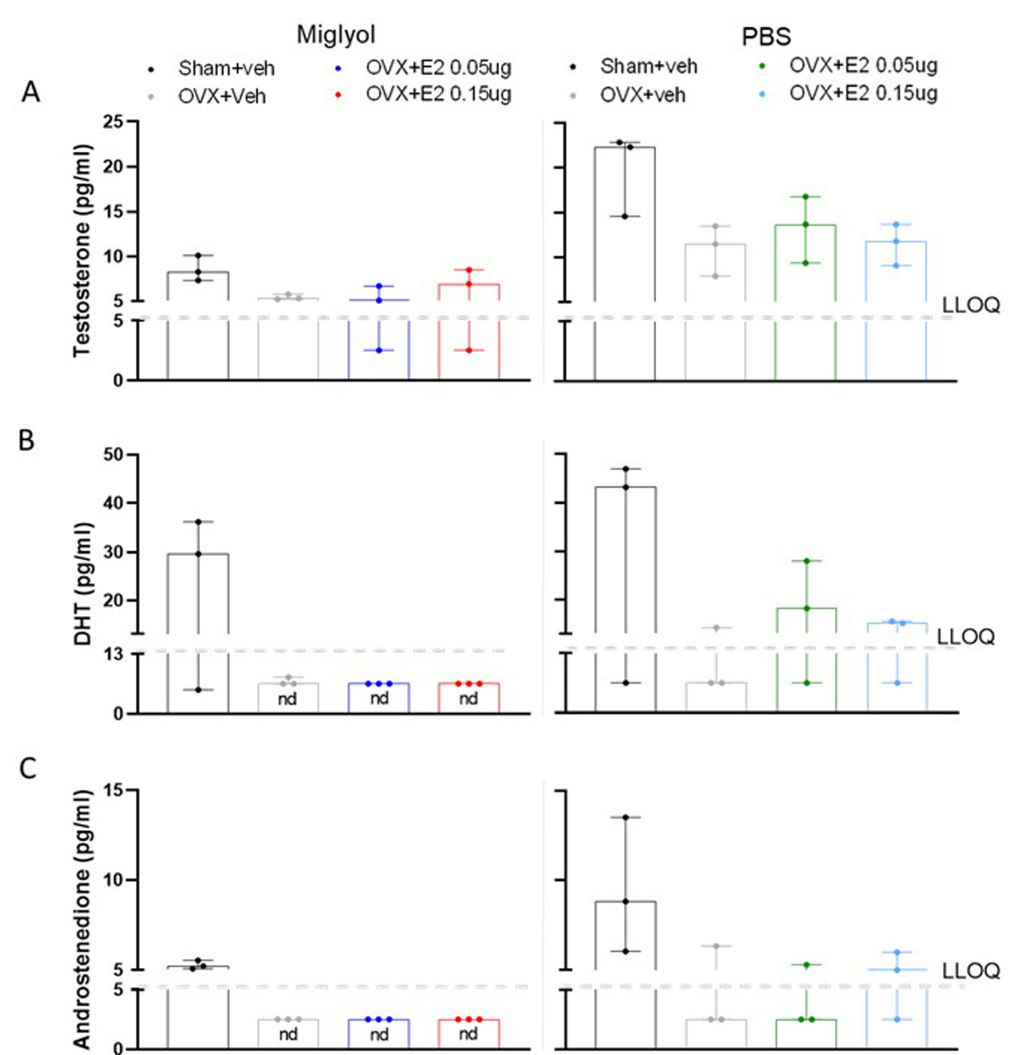
Figure 4. Levels of testosterone, dihydrotestosterone (DHT) and androstenedione in serum after 8 weeks of treatments. The amount of testosterone ( A ), dihydrotestosterone (DHT; B ) and androstenedione ( C ) was measured in Sham and OVX mice after 8 weeks of s.c. injections every 4 days with vehicle (miglyol or PBS) or 17 β-estradiol (E2; 0.05 µg/mouse or 0.15 µg/mouse). Data are expressed as median (range); n=3 for each experimental group. (nd = not detectable; LLOQ=lower level of